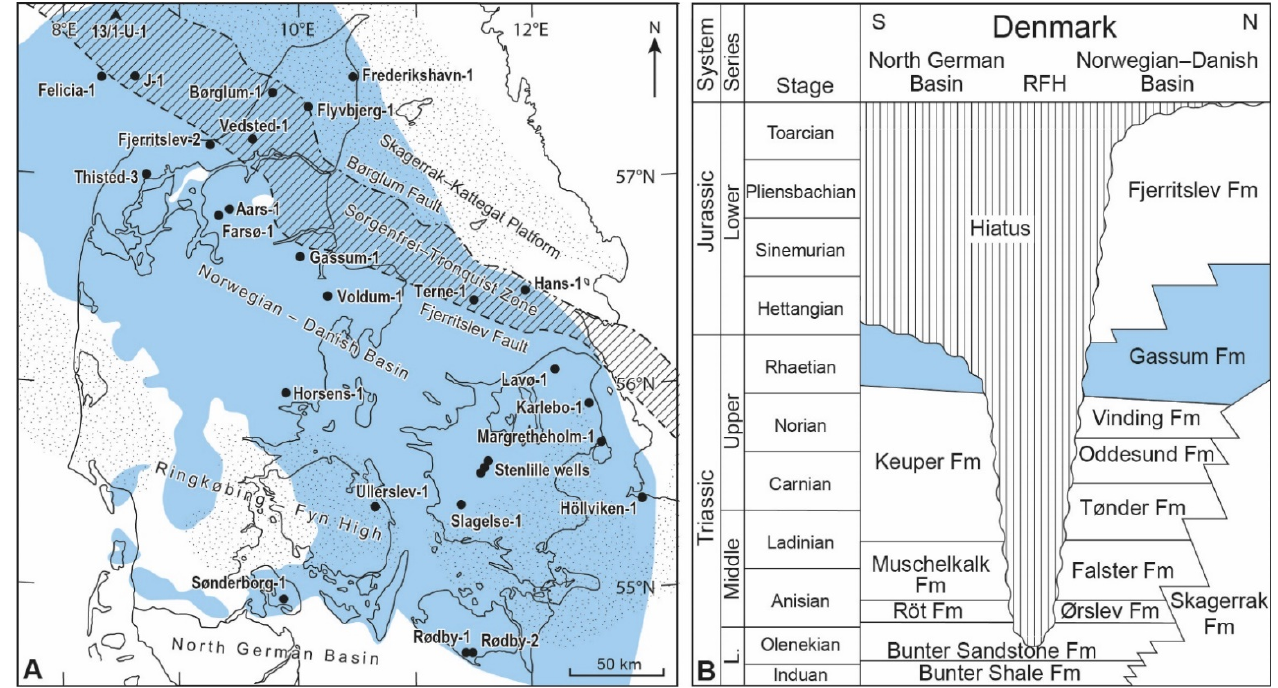
Figure 1. ( A ) Map showing structural elements and wells used in this study and with the estimated distribution of the Gassum Formation in the Danish area shown in blue. Modified from [5]. ( B ) Stratigraphic scheme of the Lower Triassic to Lower Jurassic succession onshore Denmark that is based on [24,26]. The time-transgressive nature of the top of the Gassum Formation is indicated. The Norwegian-Danish Basin and the North German Basin were separated by the Ringkøbing–Fyn High (RFH) on which less sediments were deposited, of which some were later eroded.